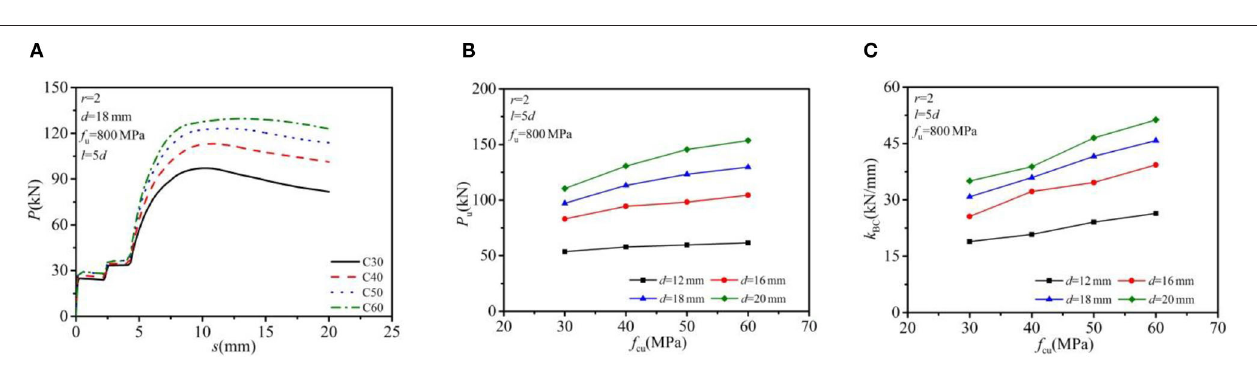
Figure 10 contours the ultimate deformation of FEM with 18 mm MBSCs. Due to the influence of the multiple bolt effect, the stress on the bolts was not uniform, and the bending deformation of bolts on the top layer (near the load) and the deformation of concrete were relatively